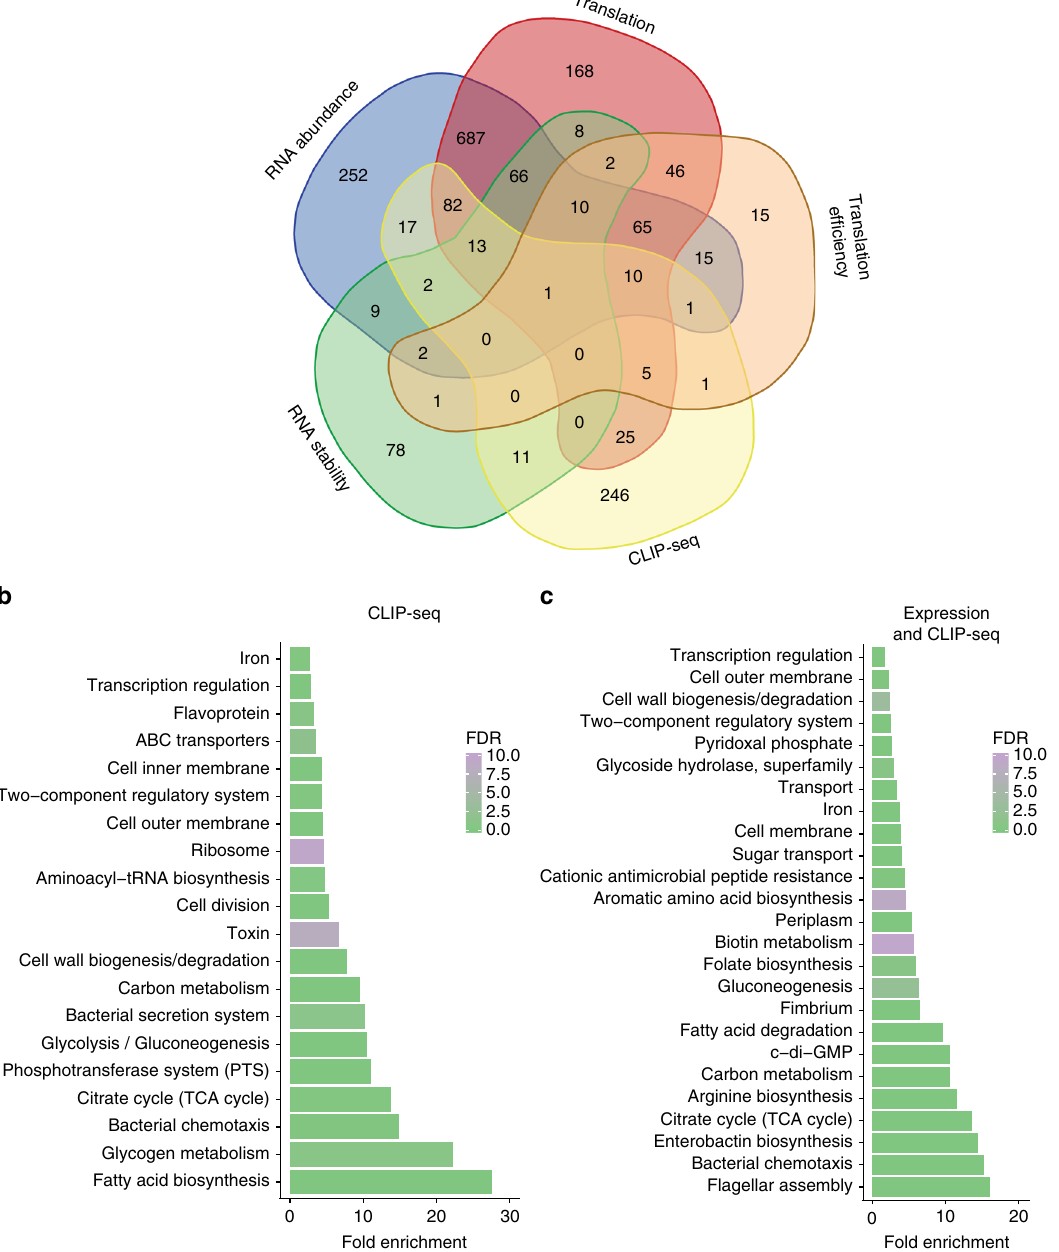
Fig. 3 Integration of transcriptomics data. a Venn diagram depicting genes with signi fi cant changes according to the different transcriptomic approaches. CLIP-seq peaks without associated annotations are not shown. A subset of enriched functional annotations as determined with DAVID 76 with the full lists in Supplementary Data 3 and 4. b Functional annotation of enriched genes that were associated with CsrA CLIP-seq peaks. c Functional annotation of differentially expressed genes between the WT and csrA mutant strains in any of our transcriptomic approaches or associated with CsrA CLIP-seq peaks. The bars are colored according to the false discovery rate (FDR) of the test for enrichment (EASE test, a modi fi ed Fisher ’ s exact